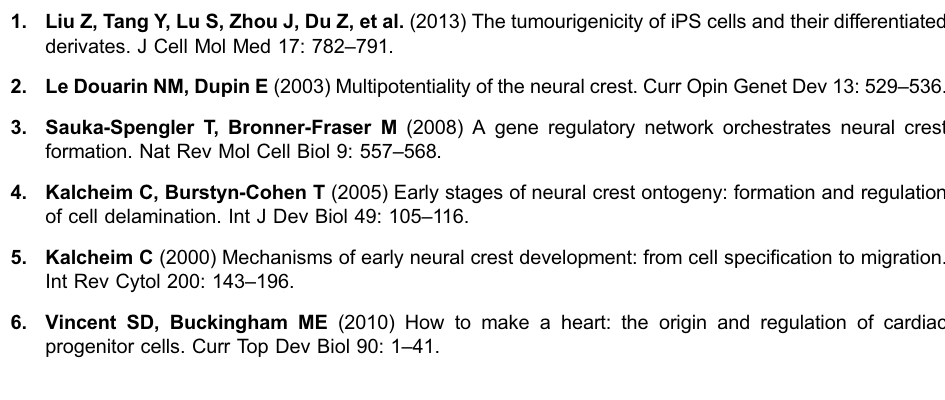
Figure S6. Osteogenic-, chondrogenic-, adipogenic induction from feeder-free hiPSCs through hNCC-derived hMSCs. Differentiation properties of hNCC- MSCs. The induction for osteogenic (OI), chondrogenic (CI), and adipogenic (AI) lineages was performed as described in the Materials and Methods section and evaluated by Alizarin Red staining (OI), Alcian Blue staining (CI), and Oil Red O staining (AI), respectively. Scale bar, 200 m m. Table S1. Information of primary antibodies used in this study. Table S2. Information of PCR primers used in this